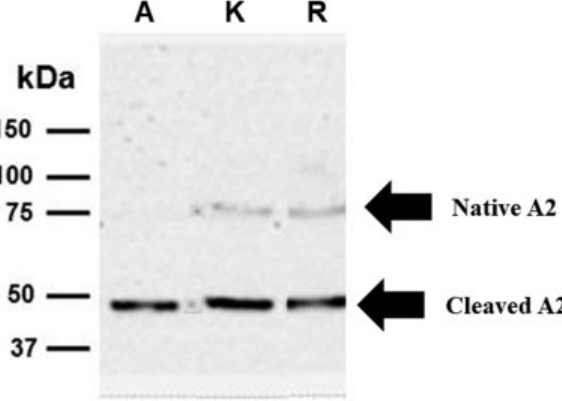
Fig. 3 Thrombin-catalyzed activation of recombinant FVIII contained in Advate (A), Kogenate (K), and Refacto AF (R). The experimental conditions are reported in the Methods section. The detection of the A2 domain was accomplished by the MoAb sc-73597. Thrombin was used at a concentration of 2.5 nM, and the hydrolysis products were analyzed after 180-minute